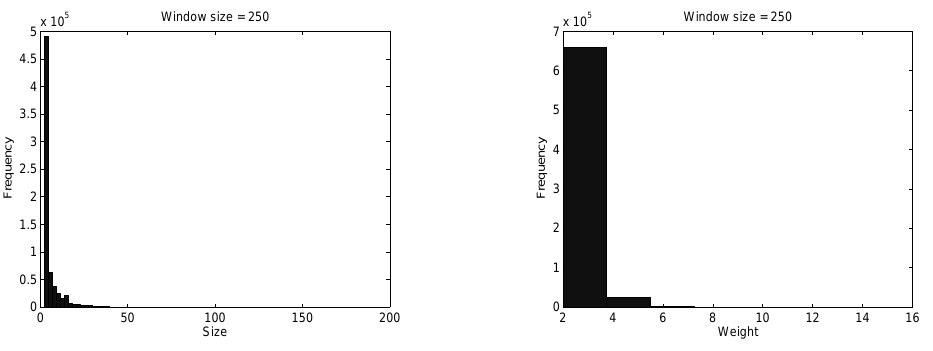
Figure 7. Distribution of the estimated social structure in a set of 680,000